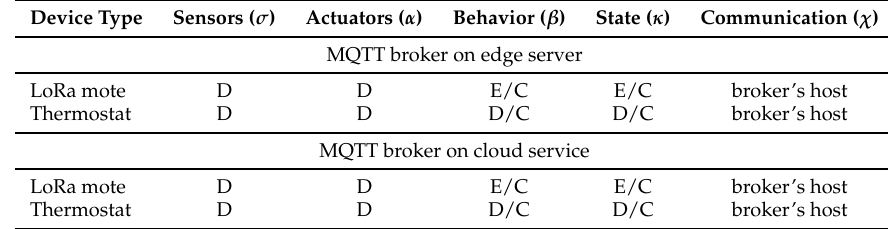
Table 2. Deployment configurations under simulation. D indicates that the component can be deployed on the local device directly, E that it can get deployed on edge, and C on cloud. Behavior ( σ ) and state ( κ ) components must be located onto the same host (device-device, edge-edge, cloud-cloud).